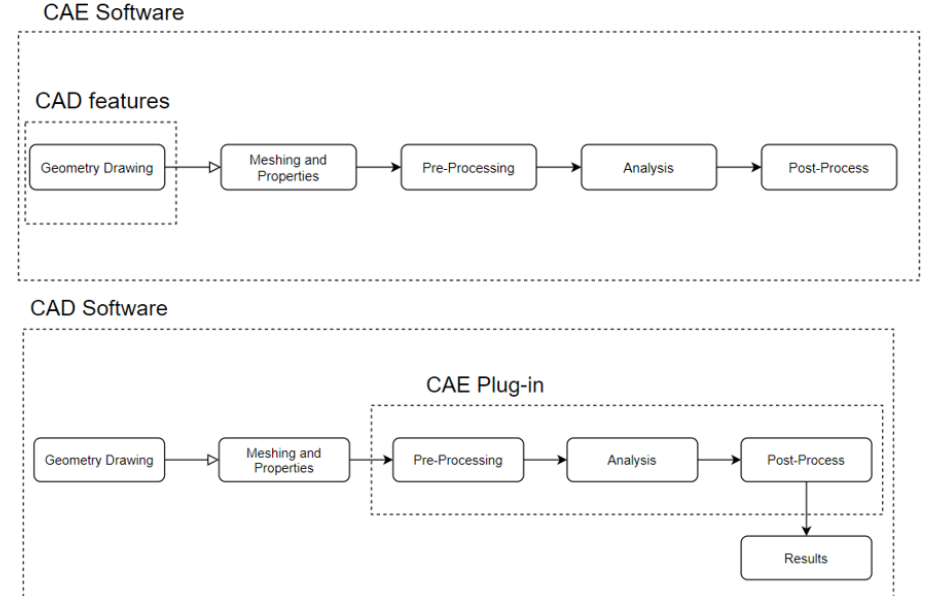
Figure 6: Possibilities in CAD/CAE integration